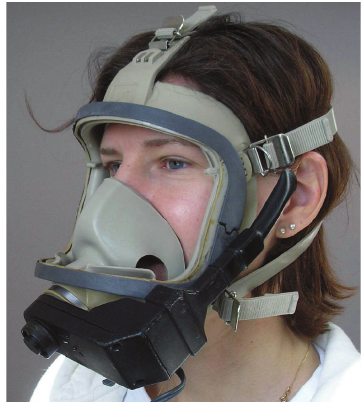
Figure 3: Air mask with radio unit.